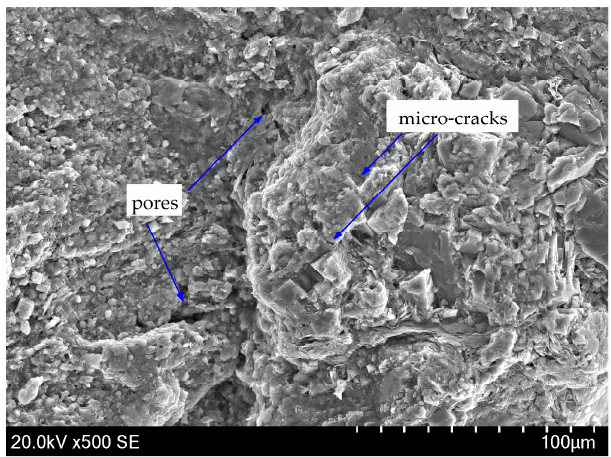
Figure 2. The typical microstructure photograph of the intact sandstone sample.